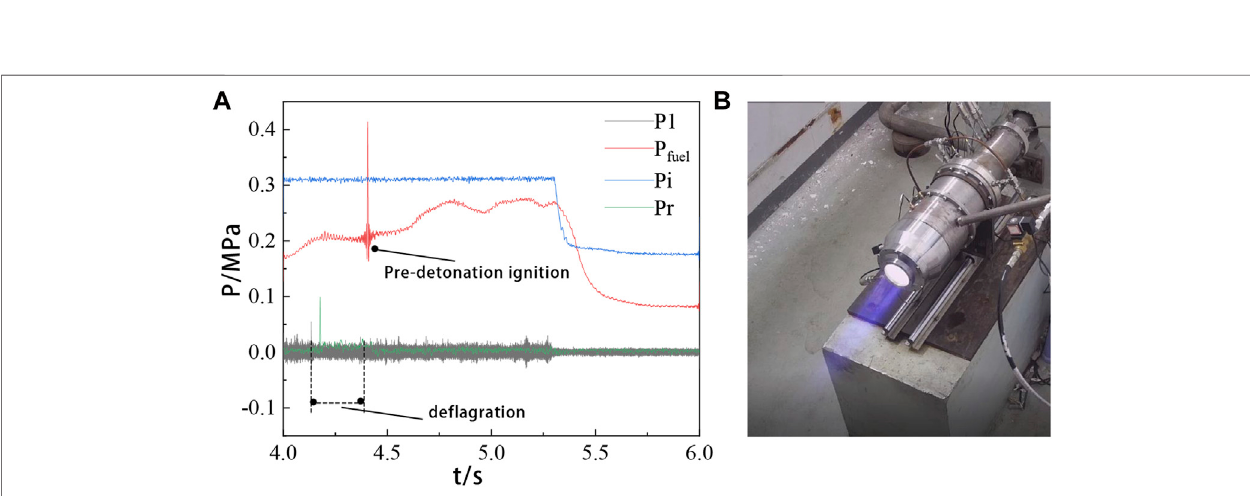
FIGURE 12 | Results of operating at T 0 (cid:1) 650K, _ m air (cid:1) 1 . 5kg/s, φ (cid:1) 0 . 95. (A) Static pressure signals and high-frequency pressure signals by P 1 ; (B) The Photograph of RDE.